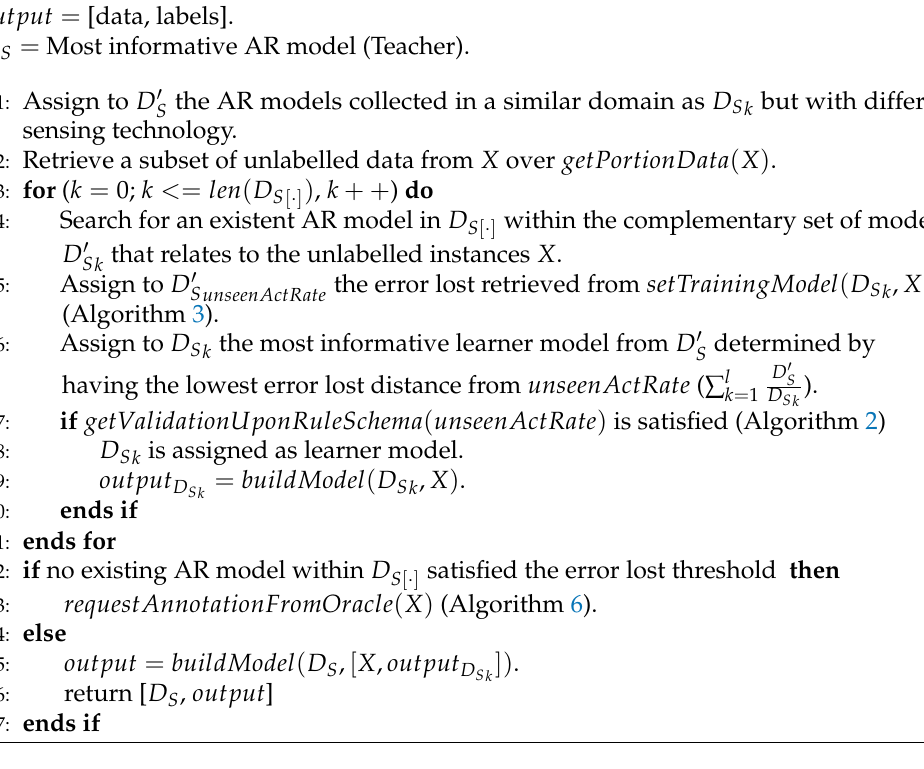
Algorithm 8 Selection of complementary AR models in which technological characteristics differ from those of a given